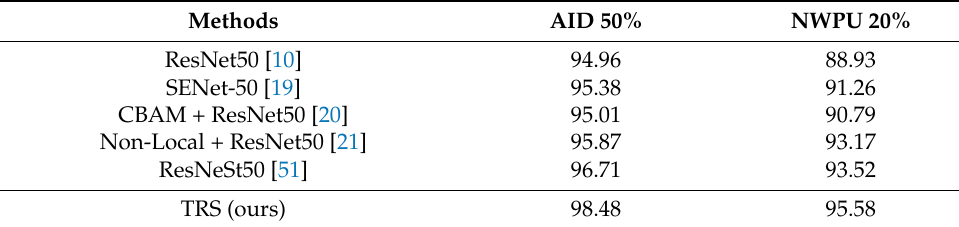
Table 7. Comparison with other attention